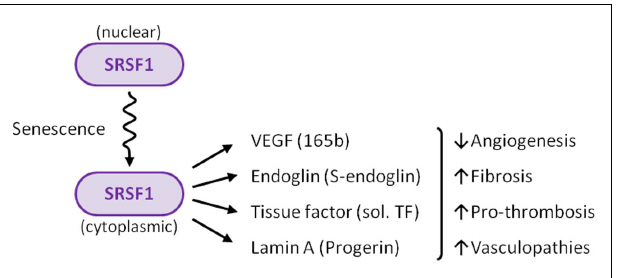
FIGURE 3 | Summary of the role of SRSF1 in ECs. Several stimuli, including senescence, induce translocation of SRSF1 to the cytoplasm. SRSF1 is a key factor that modulates the expression of critical regulators of vascular physiology, includingVEGF, endoglin, tissue factor (TF), and lamin